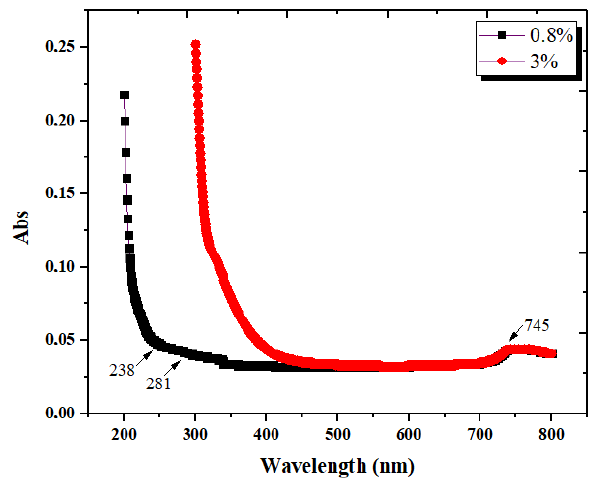
Figure 10. UV-Vis spectrum of the LC extract at two different concentrations. 3.1.6. Determination of Protein Content of the LC Extract According to the OPA assay for protein quantitation, the fluorescent emission of the